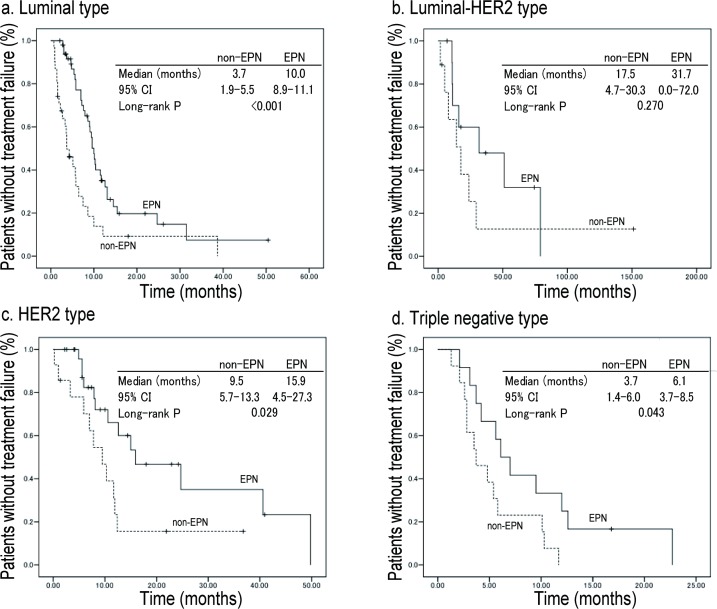
Kaplan-Meier plots for TTF according to subtypes.Among the four subtypes, TTF was 10.0 months in the EPN group and 3.7 months in the non-EPN group in the luminal type (p = <0.001); 31.7 months in the EPN group and 17.5 months in the non-EPN group in the luminal-HER2 type (p = 0.270); 15.9 months in the EPN group and 9.5 months in the non-EPN group in the HER2 type (p = 0.029); and 6.1 months in the EPN group and 3.7 months in the non-EPN group of the triple negative type (p = 0.043).